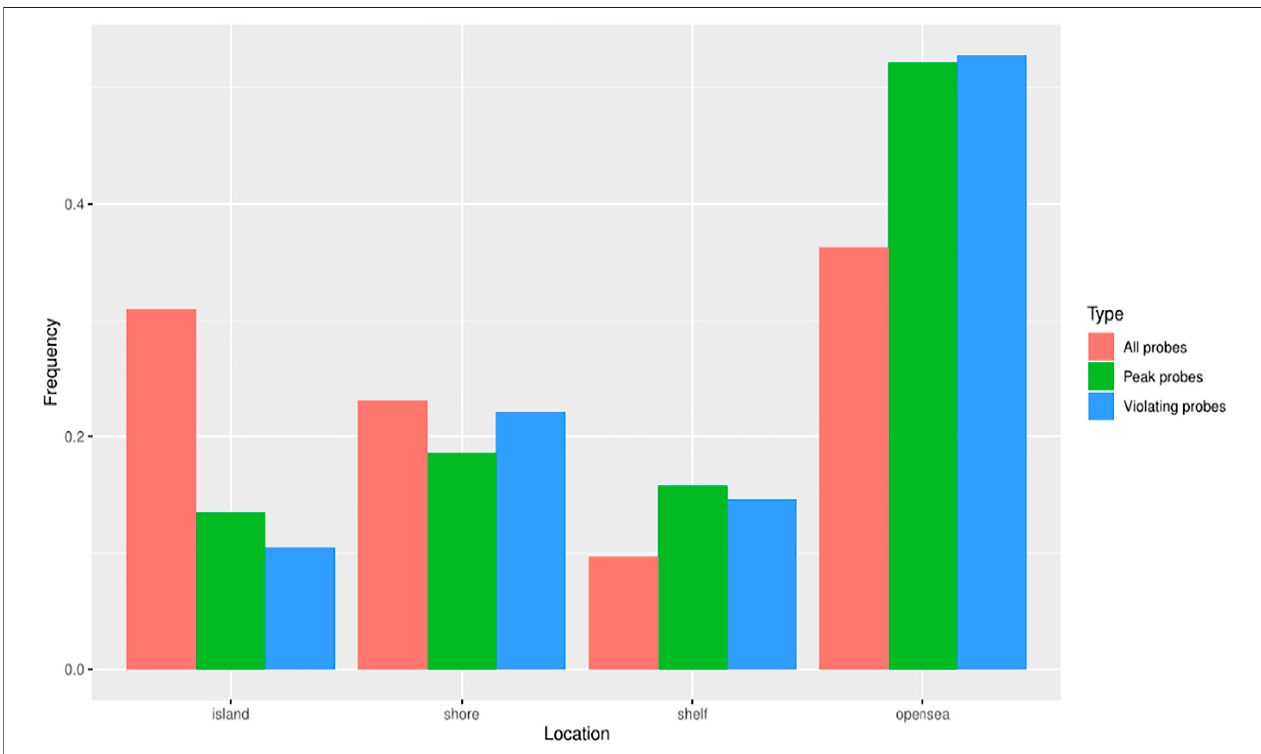
FIGURE 7 | Genomic loci classi fi cation of the probes. Violating and peak probes were less frequently located in CpG islands compared to all probes. Violating probes - probes with at least one discordant beta value. Peak probes - probes appearing in the peak of residuals below − 0.6.